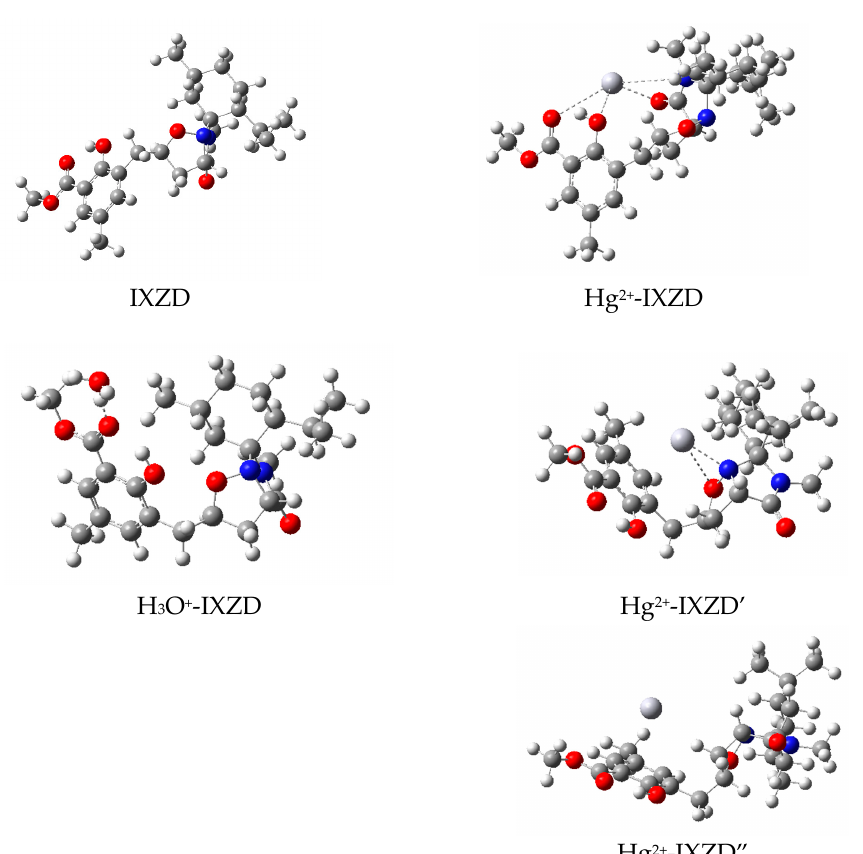
Figure 9. Complexes L, H 3 O + ‐ L, and Hg 2+ ‐ L models optimized by DFT with solvation model SMD and water. Table 2. Values of relative energies of the Hg 2+ Complexes with solvation model SMD and water. Complex